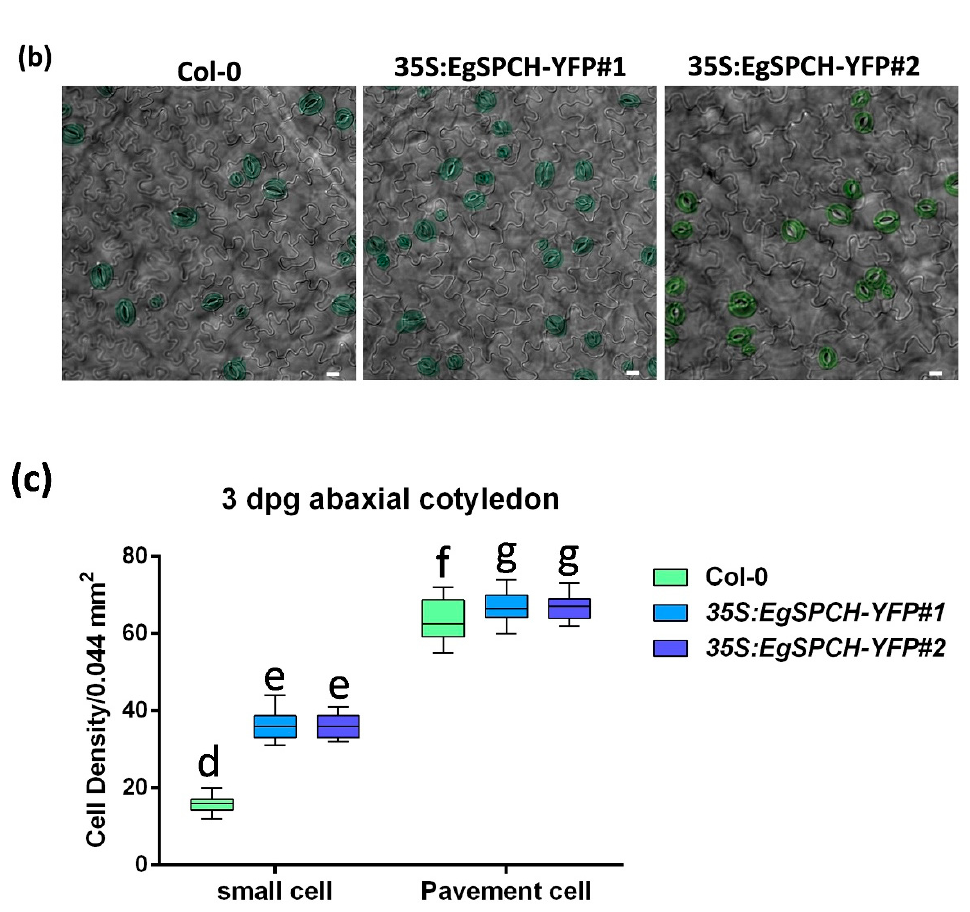
Figure 5. ( a ) Subcellular localization of EgSPCH in the abaxial cotyledons of 3 dpg Arabidopsis seedlings. S: stomatal lineage ground cell (SLGC); M: meristemoid; P: pavement cell; GM: guard mother cell. ( b ) The stomatal development of the 7 dpg abaxial cotyledons of Col-0 and the two transgenic 35S:EgSPCH-YFP(#1 and #2) in Arabidopsis. ( c ) The small cell number and pavement cell number of Col-0 and two transgenic 35S:EgSPCH-YFP. Scale bar = 10 µ m. Values are mean ± SD; n = 20. One-way ANOVA with post-hoc Tukey HSD; p <